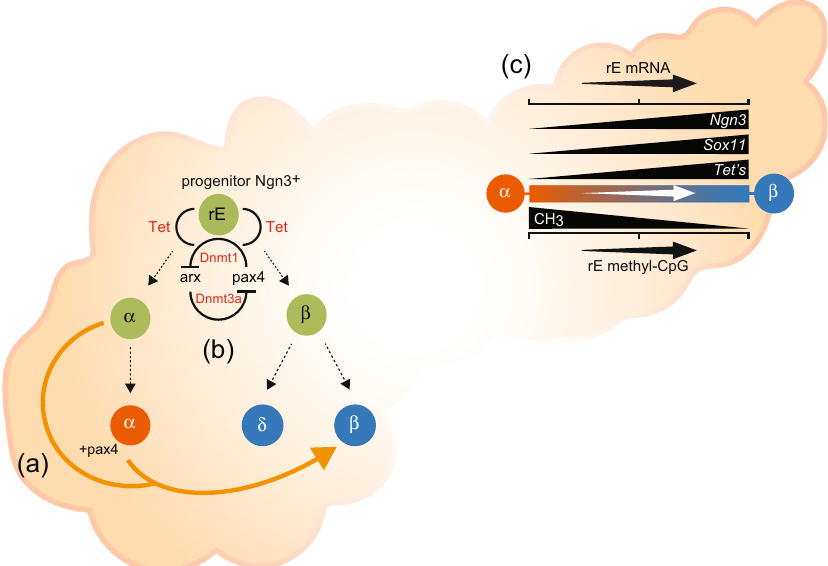
Fig. 2 Model of DNA demethylation-mediated reprogramming (dmrE). Proposed schematic model of DNA methylation as an epigenetic barrier for islet transition and reprogramming in the pancreas. a Pax4 overexpression in adult α -cells (orange) induce their trans-differentiation and conversion into β -like cells (blue). This leads to a shortage in glucagon, which is responsible for the mobilisation of ductal precursor cells (green), these re-expressing the pro-endocrine gene Ngn3 (green), prior to undergoing an EMT and concomitant differentiation into endocrine cells. Such a continuous cycle of conversion/regeneration results in insulin + cell hyperplasia. b Methylation writing (DNMT ’ s) and erasing (Tet ’ s) enzymes are implicated in the regulation of Arx and Pax4 , respectively. c Re-expression of Ngn3 is inversely associated with loss of DNA methylation in the ArxKO knockout and Pax4 misexpression animal models. This model of DNA demethylation-mediated reprogramming or dmrE closely corresponds with Tet expression and the loss of gene methylation content and enhanced activity of the mesenchymal marker Sox11